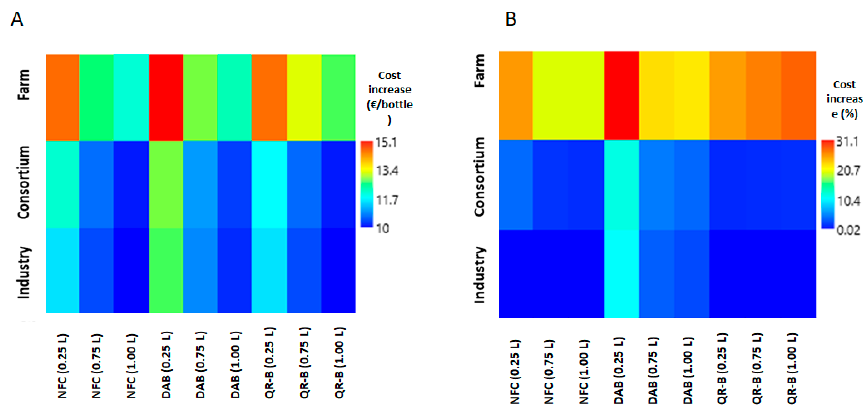
Figure 3. ( A ) Matrix plot of the cost increase per bottle in relation to the technology used and the production level. ( B ) Matrix plot of the cost increase, in percentage, in relation to the technology used and the production level.